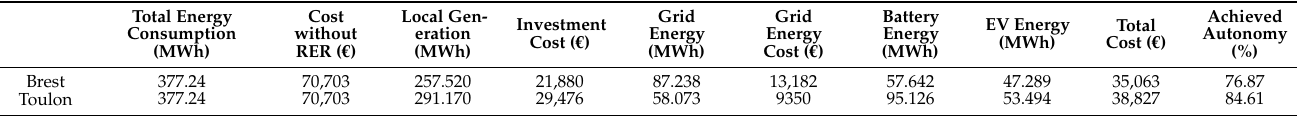
Table 6. Case study 2: Energy cost and achieved autonomy with